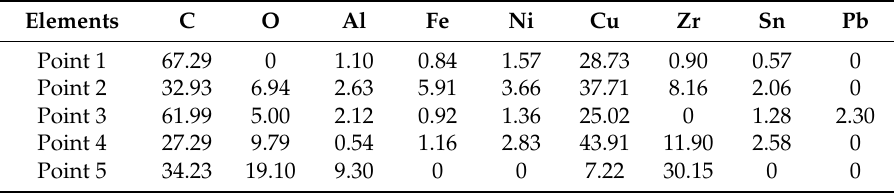
Table 4. Summary of EDS analysis conducted at selected locations shown in Figure